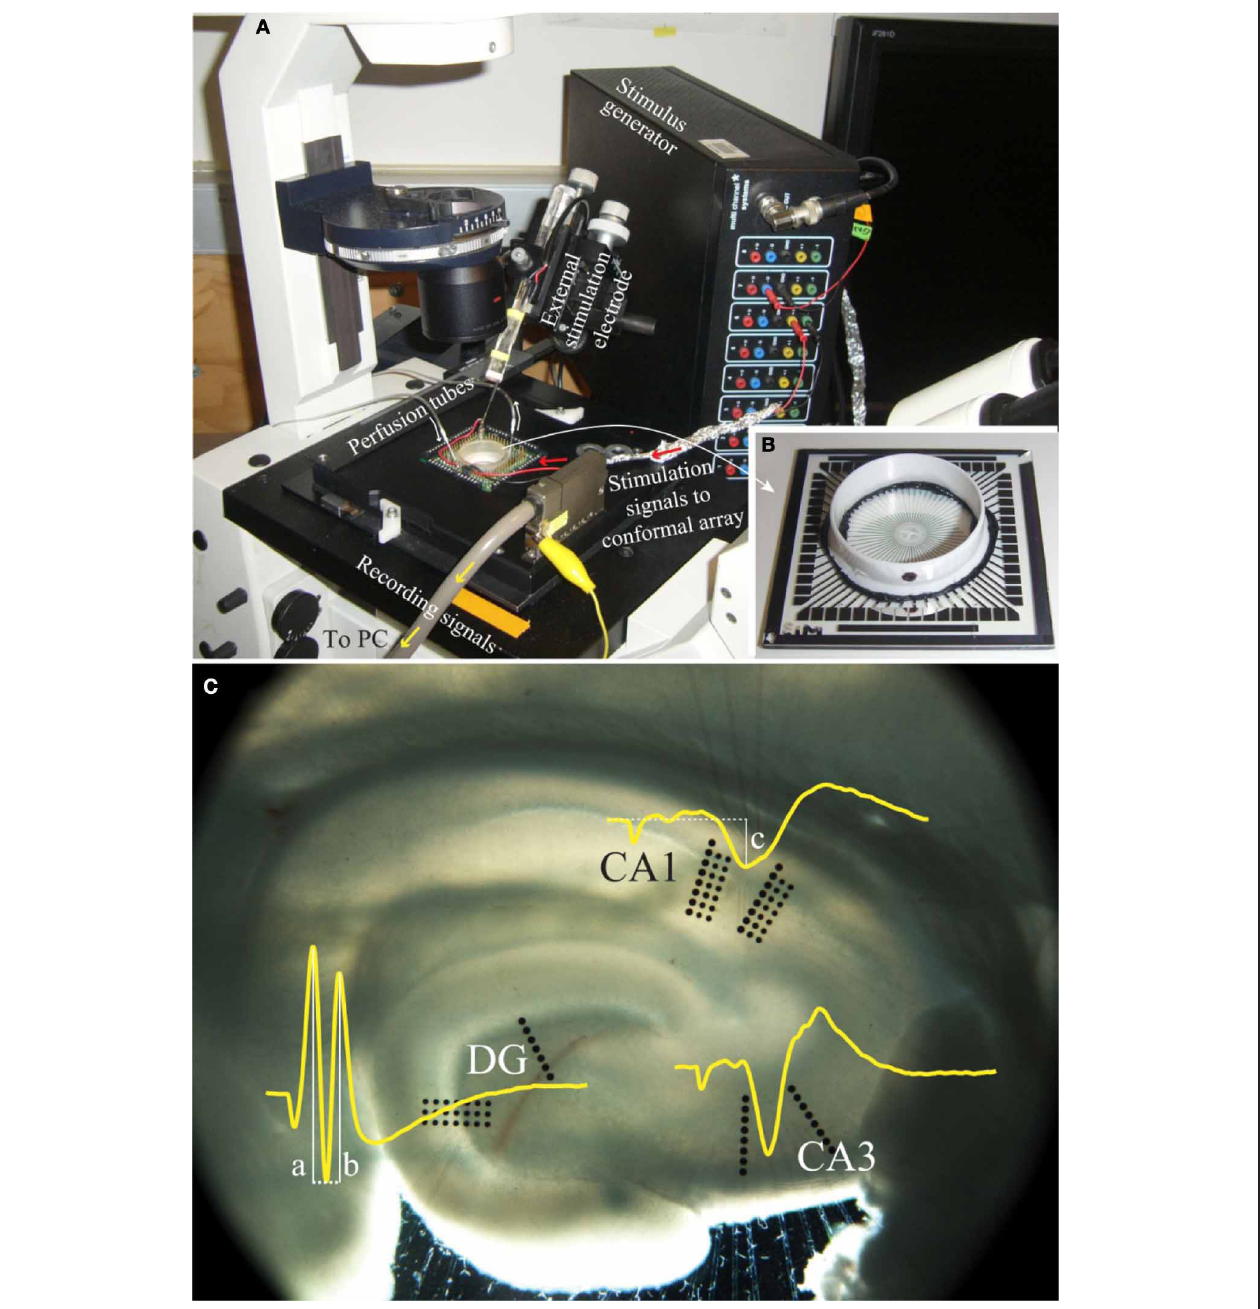
FIGURE 2 | A photo of the electrophysiological recording system. (A) The MEA60 system and (B) the conformal planar MEA (Gholmieh et al., 2006; Taketani and Baurdy, 2006). (C) A photomicrograph of a hippocampal slice on the conformal MEA. The set alignment of this array is according to rat hippocampal cytoarchitecture covering major subregions